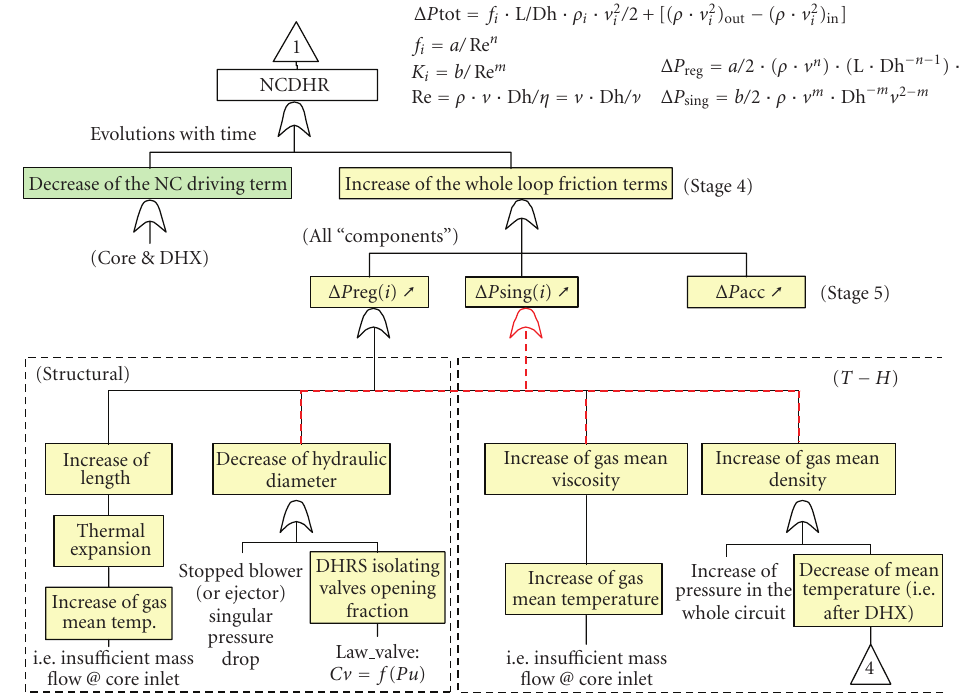
Figure 10: Development of the deductive approach for critical parameters determination (NCDHR pressure drops